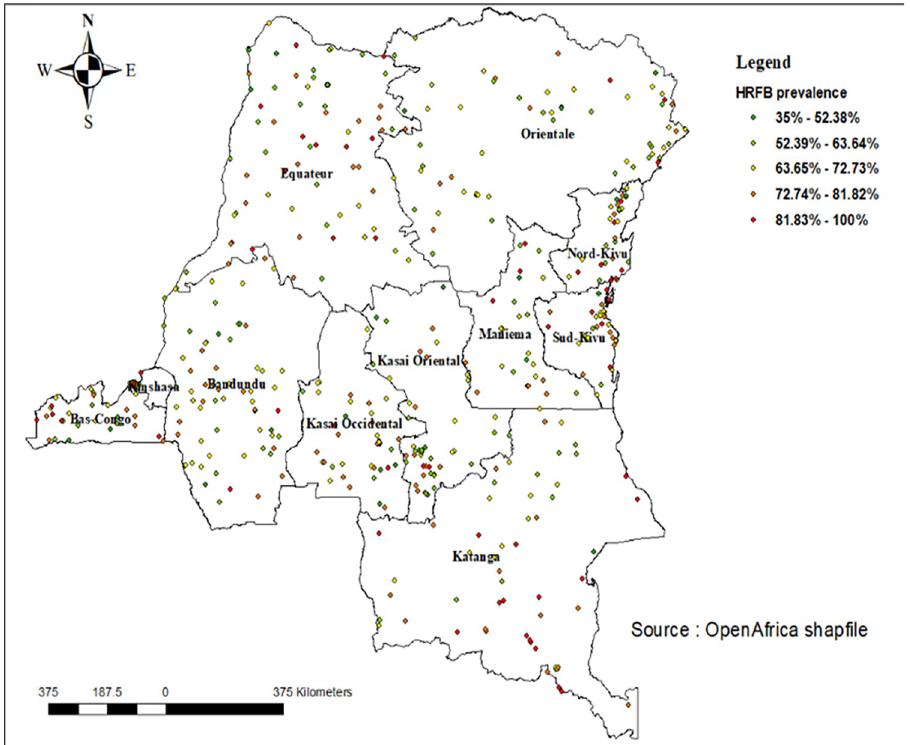
Fig 4. Spatial distribution of high-risk fertility behaviours among married women in the Democratic Republic of the Congo.